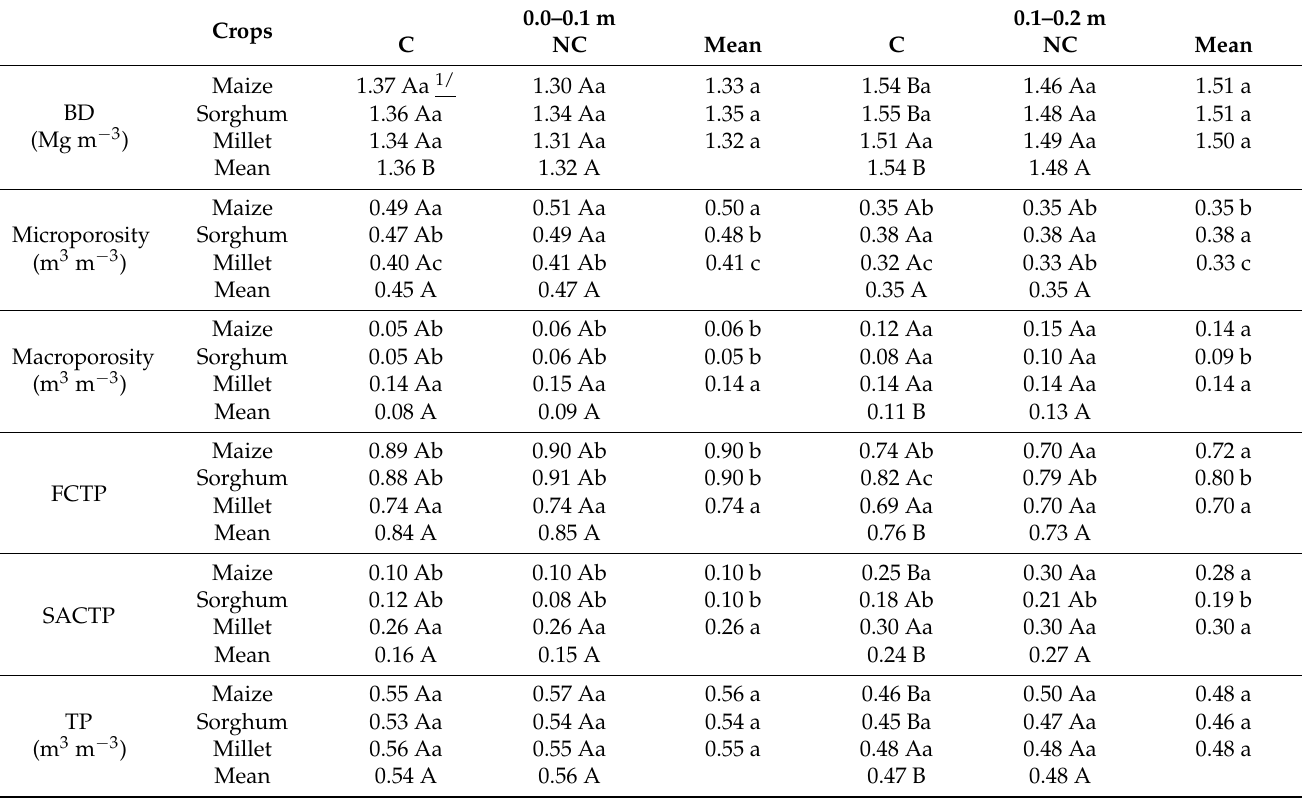
Table 2. Mean values of soil physical properties (field capacity—FC; soil aeration capacity—SAC; soil water storage capacity—FCTP; air storage capacity—SACTP; total porosity—TP; soil bulk density—BD) in the 0.0 to 0.1 and 0.1 to 0.2 m soil layers after second-season crops of maize, sorghum, and millet in compacted (C) and uncompacted (NC) soils.